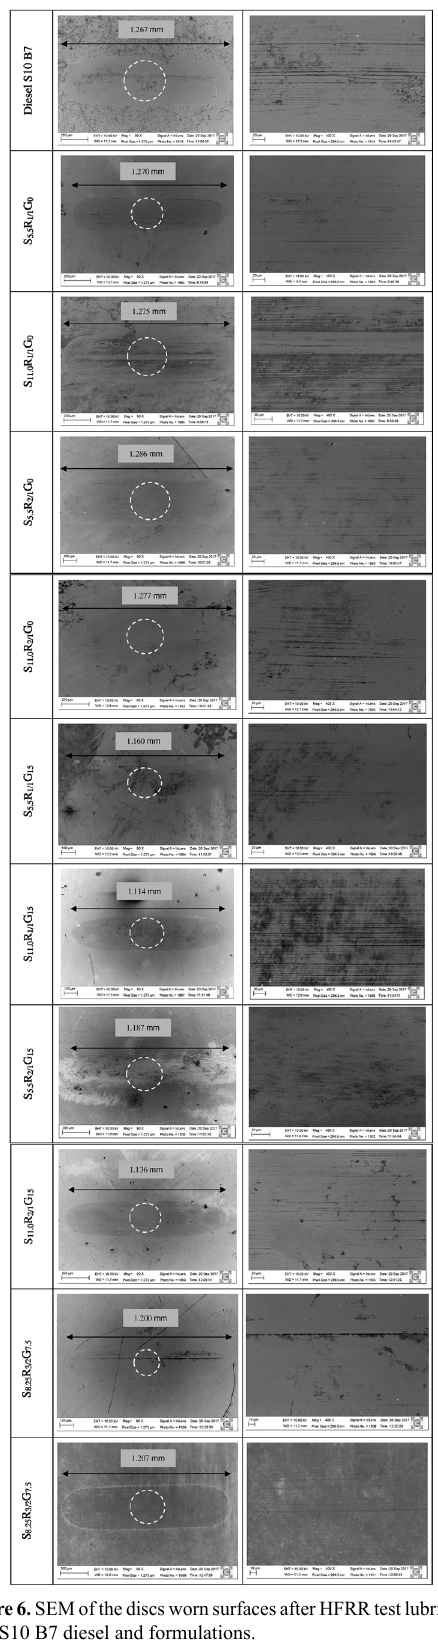
Figure 6. SEM of the discs worn surfaces after HFRR test lubricated with S10 B7 diesel and